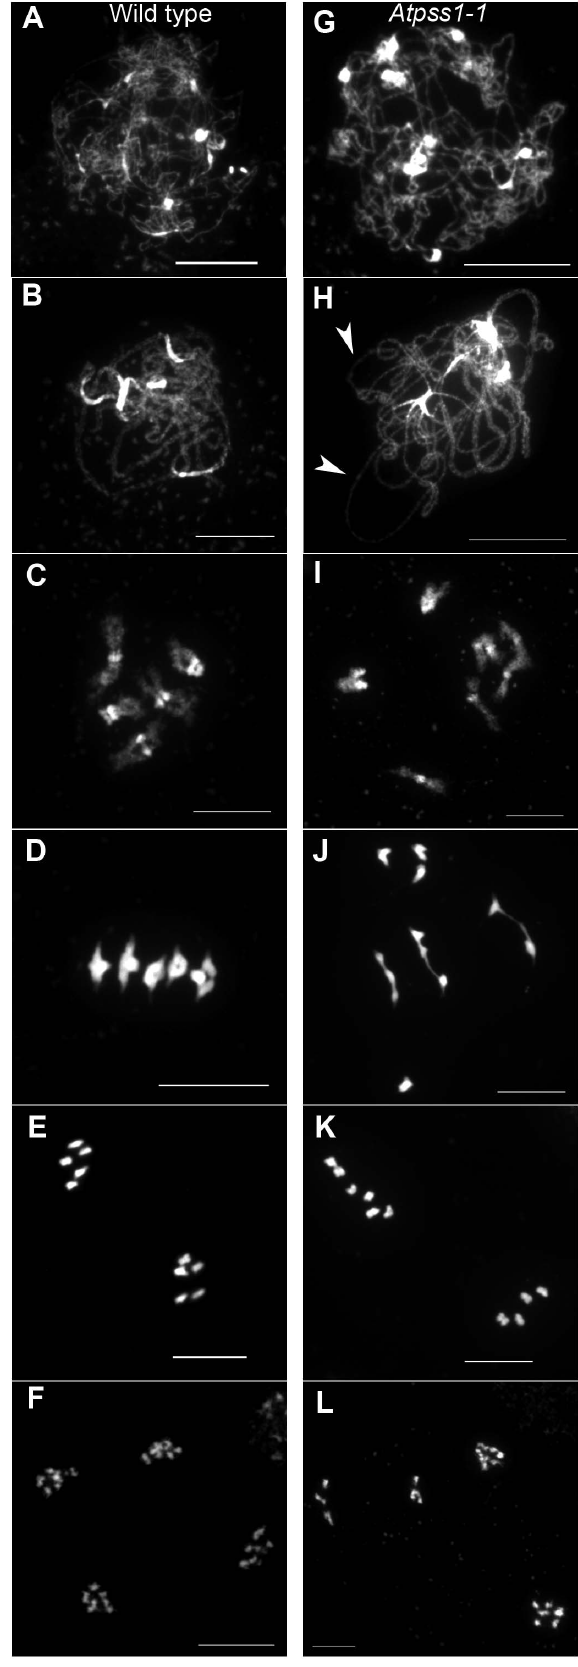
Figure 2. Chromosome spreads of male meiocytes in wild type and Atpss1-1 . (A,G) Leptotene. (B,H) Pachytene. Arrowheads show unsynapsed regions. (C,I) Diakinesis. (D,J) Metaphase I. (E,K) Metaphase II. (F,L) Telophase II. Chromosome were spread according to Ross et al. [40] and stained with DAPI. Scale bar=10 m